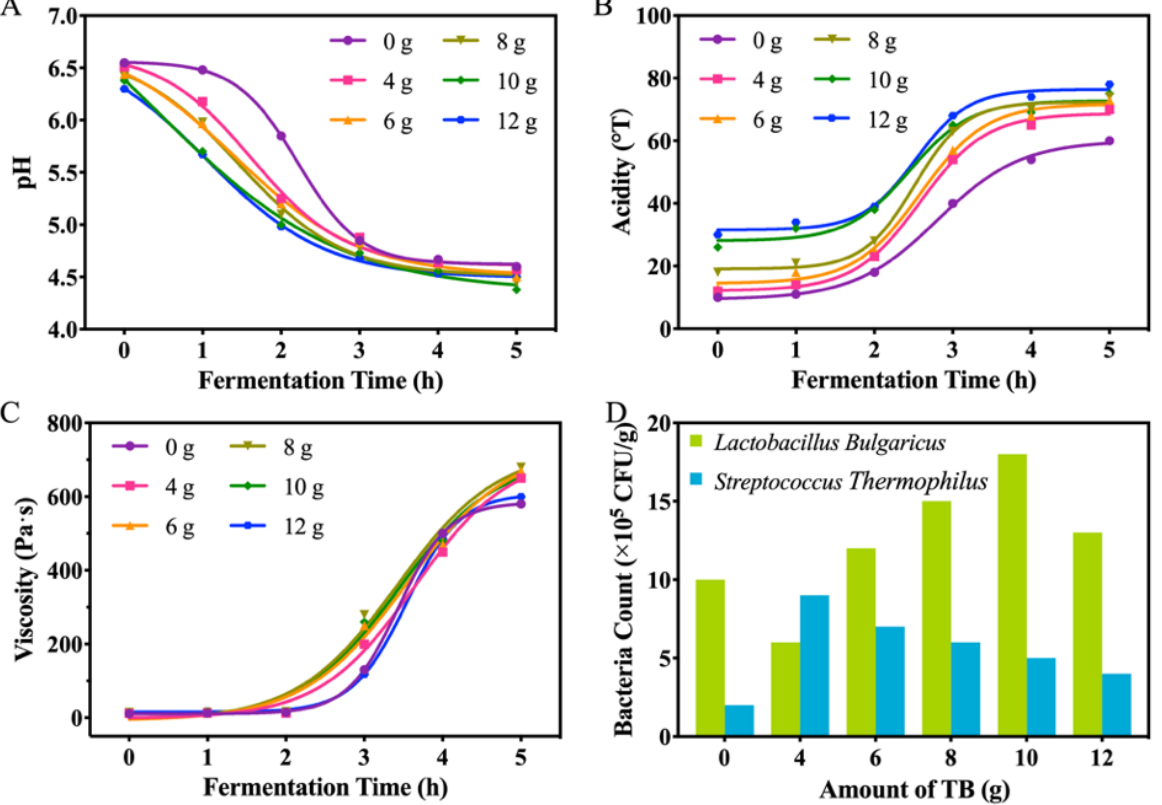
Figure 1. pH ( A ), total titratable acidity ( B ), apparent viscosity ( C ), and bacteria count ( D ) of yogurt with different TB addition during fermentation.